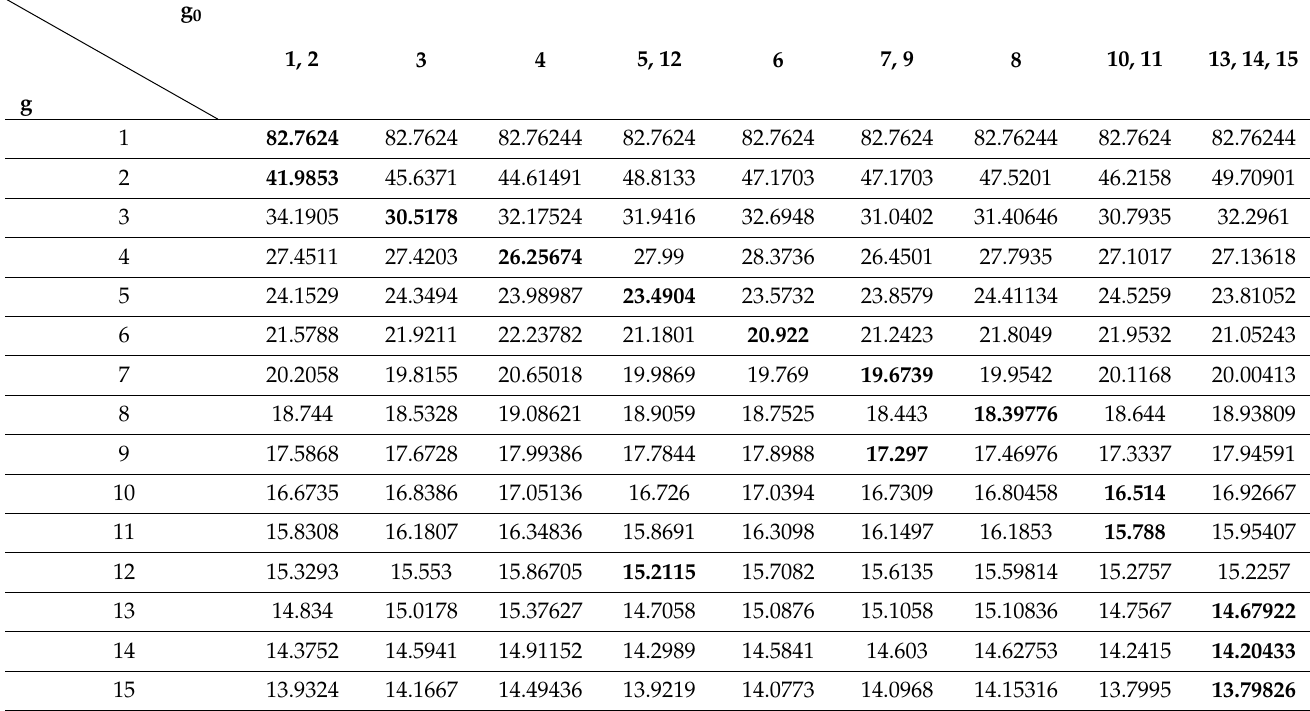
Table 2. The 15 × 15 fragment of Dynamic Table of (1774 × 272) 2 = 232,833,270,784 σ values denoting image approximations 1 .